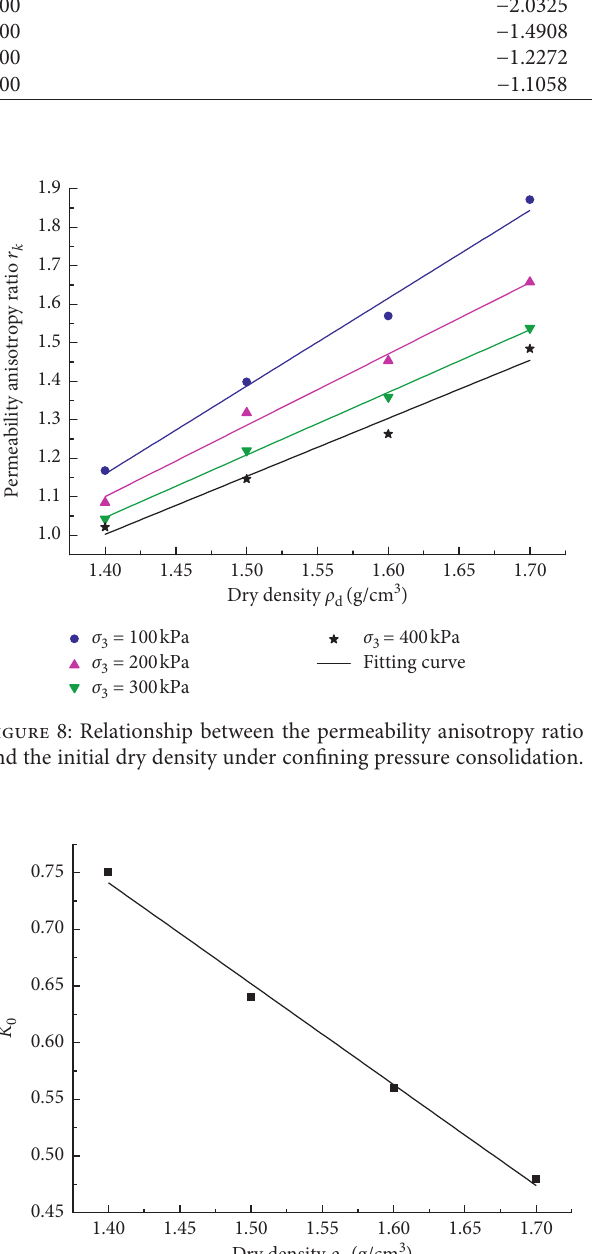
0 coefficient and the initial dry